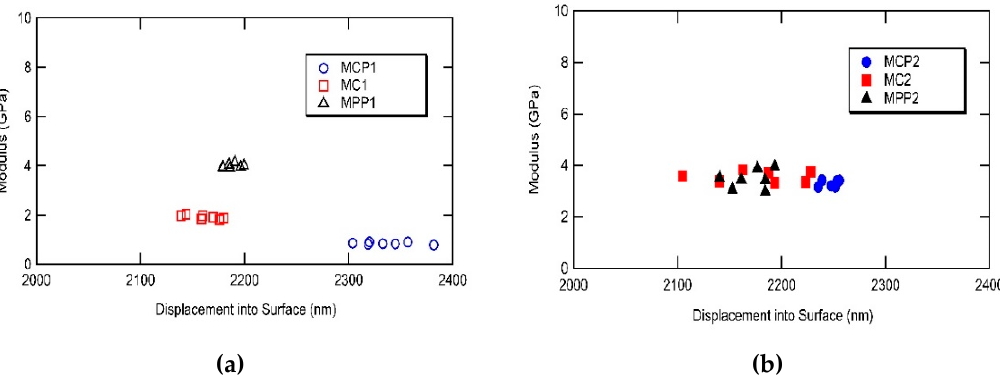
Figure 5. Young modulus calculations with respect to the three collagen membranes before ( a ) and after PRGF treatment ( b ). Legend: MPP1/MPP2 = Cova TM Max membrane before/after PRGF treatment; MC1/MC2 = Jason ® membrane before/after PRGF treatment; MCP1/MCP2 = Biocollagen ® membrane before/after PRGF treatment.